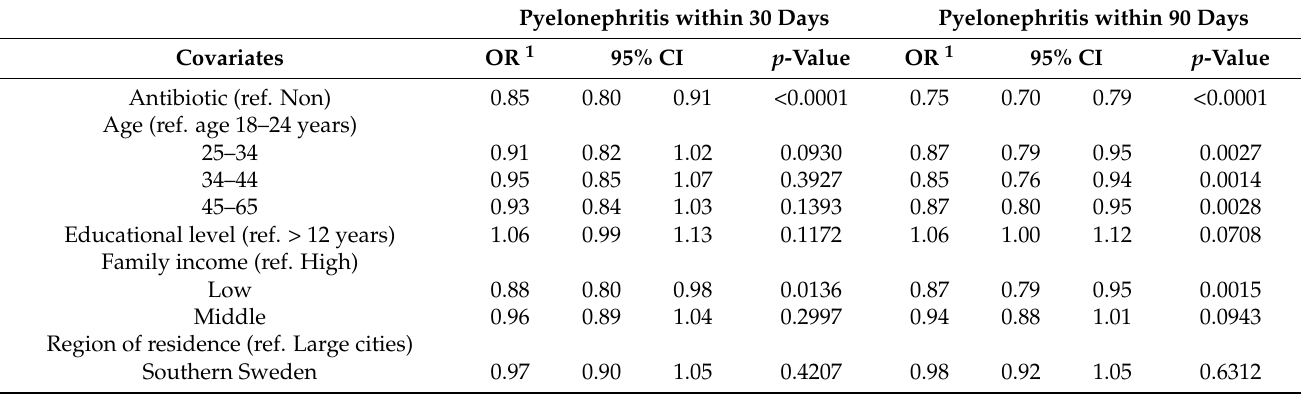
Table 4. The association between antibiotic treatment (redeemed within five days) for acute uncom- plicated cystitis and acute outpatient pyelonephritis diagnosed within 30 days and 90 days from the cystitis event, adjusted for sociodemographic factors, cervical cancer, and parity (2006–2018). Pyelonephritis within 30 Days Pyelonephritis within 90 Days Covariates OR 1 95% CI p -Value OR 1 95% CI p -Value Antibiotic (ref.